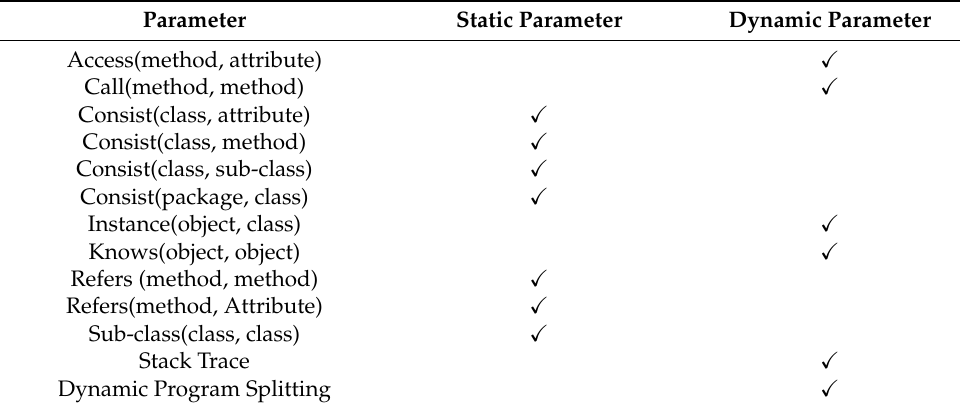
Table 1. Table representing the categories of various parameters.